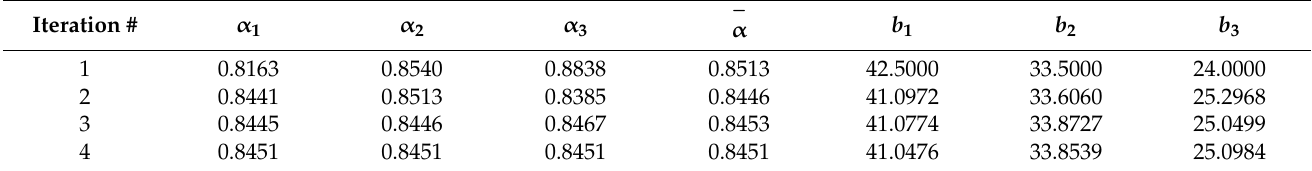
Table 6. Method application results for four coordination